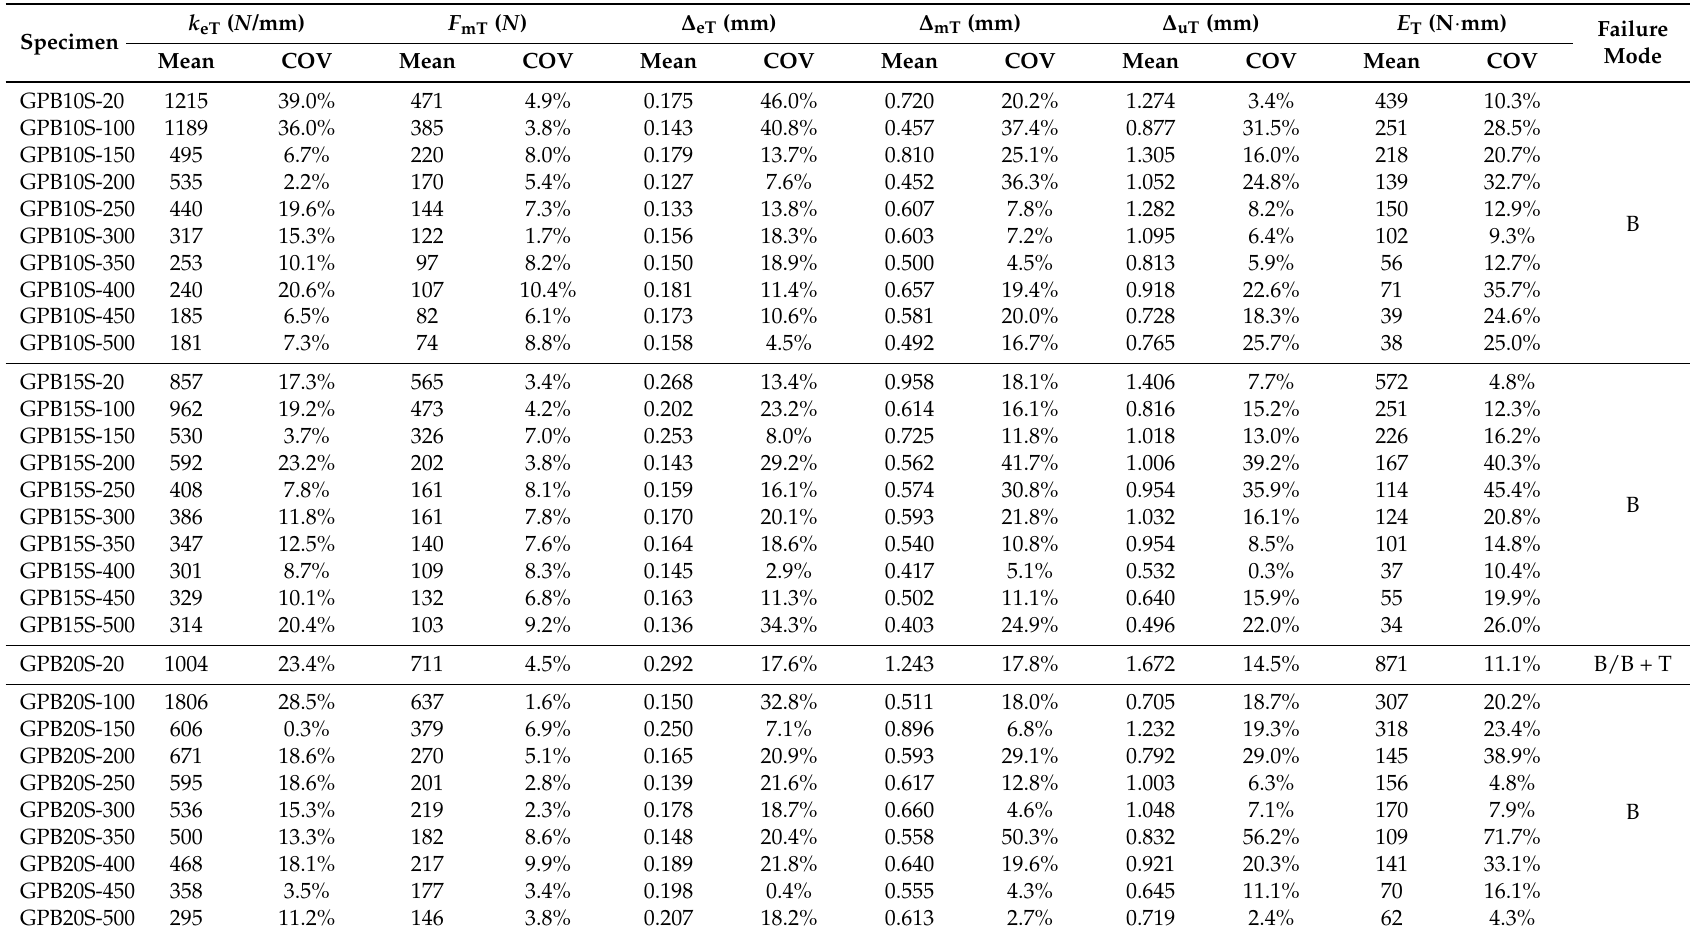
Table 1. Experimental results of CFS screw connection with single-layer gypsum